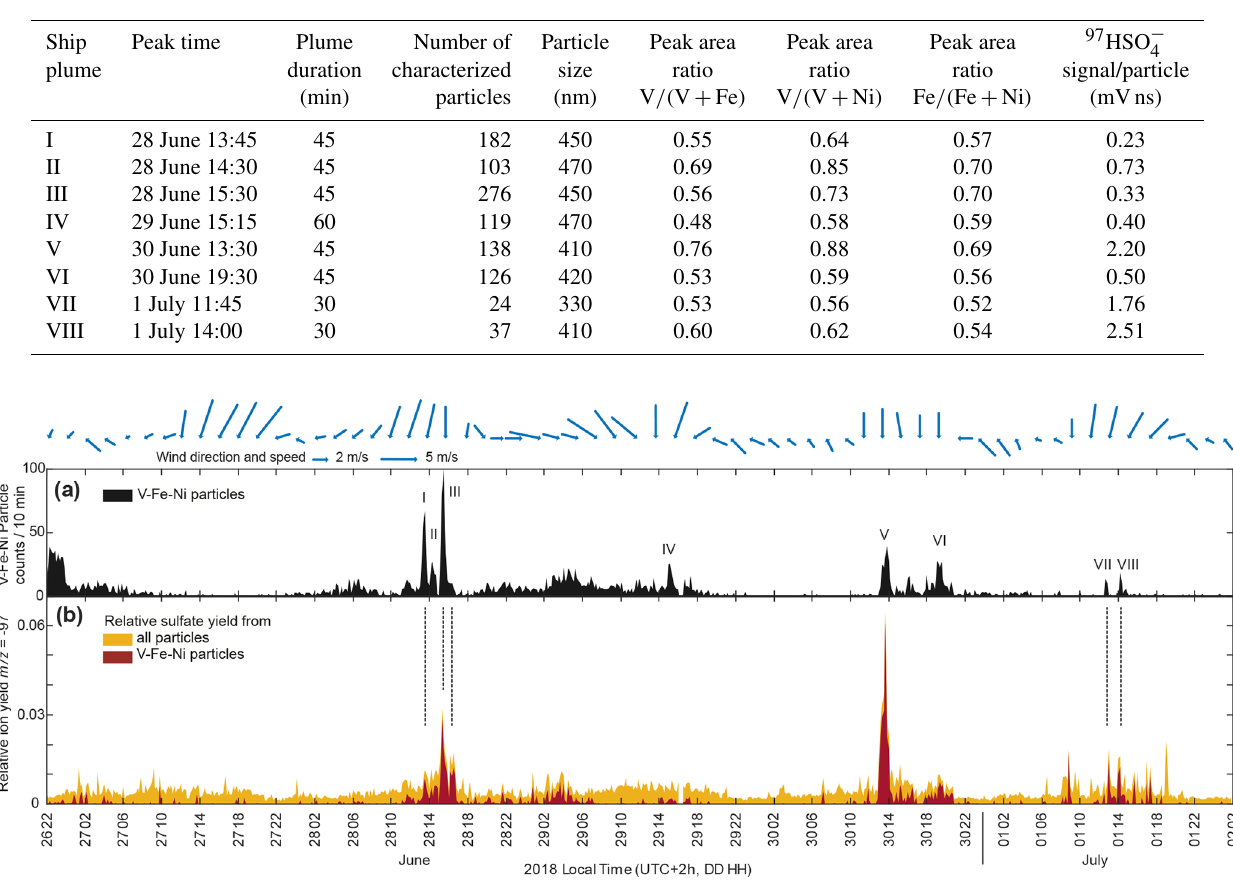
Figure 5. (a) Time series of V–Fe–Ni particles (same as Fig. 3e). (b) Yellow area: the ion yield of HSO − per 10min reveals coinciding sulfate events for some of the V–Fe–Ni features. The majority of sulfate is detected on the V–Fe–Ni particles themselves (brown area). Most of these particles belong to cluster 183 in Fig. 4.